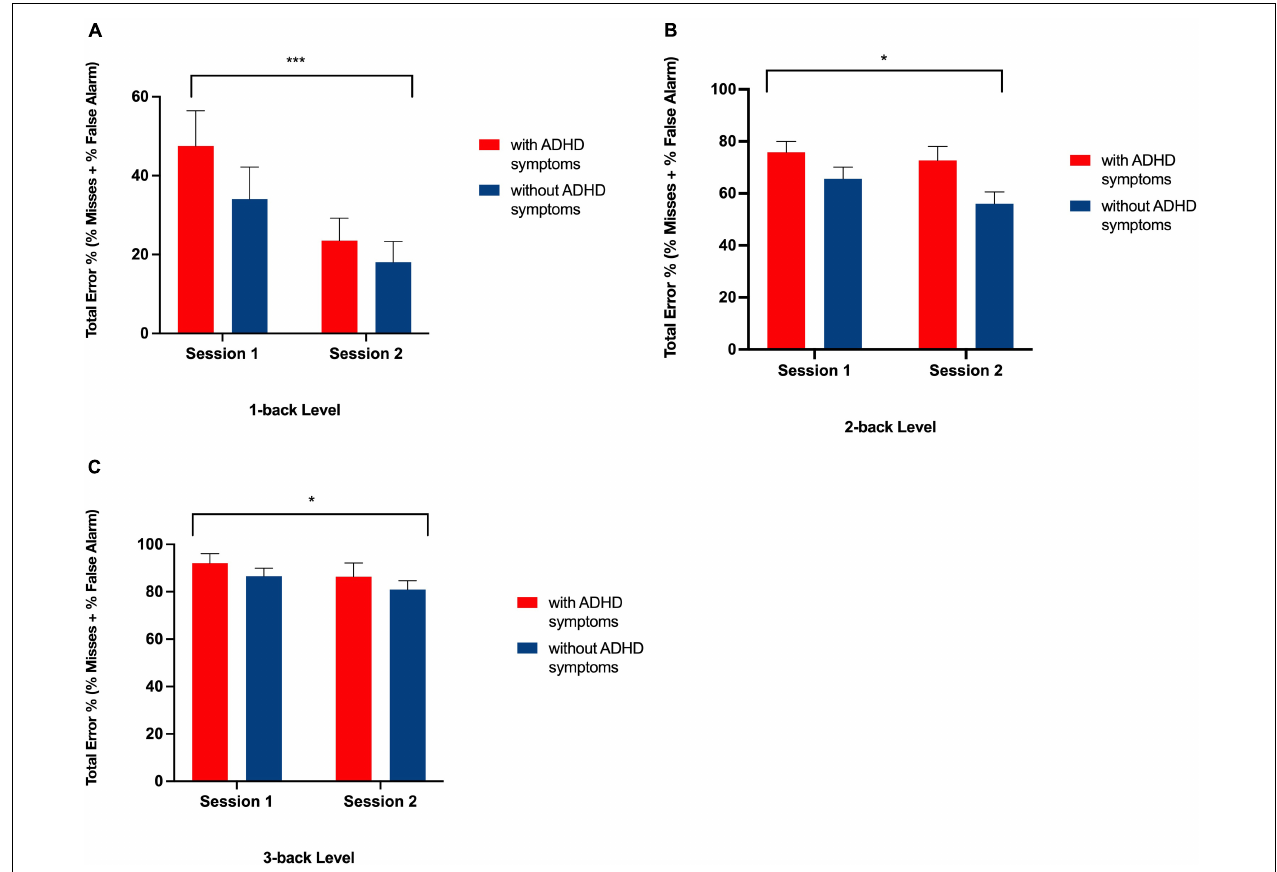
FIGURE 4 | Bar graph showing total error rates on the N-back task at Session 1 and Session 2 for each group at the 1-back (A) , 2-back (B) , and 3-back (C) level. ***Indicates a significant main effect of session, p < 0.01, * indicates a significant main effect of session, p < 0.05 with more errors being made at Session 1 than at Session 2 in both